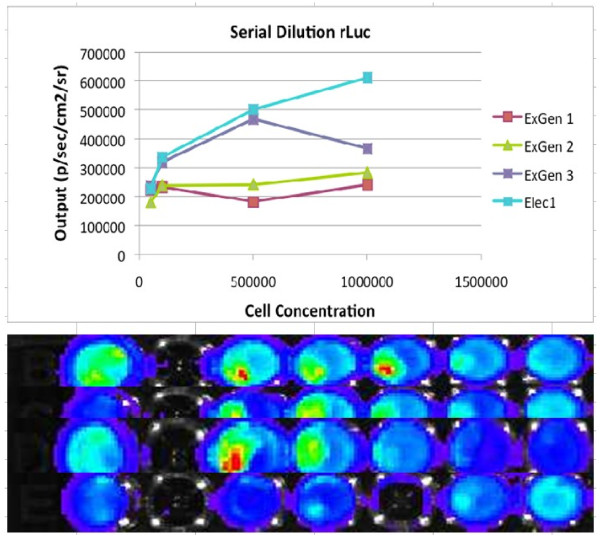
Three independent DLD1/SV-rLuc/ExGen and Two independent DLD1/SV-rLuc/ELec clones were seeded in 96-well plates at different cell densities, ranging from 5 × 10 cells/well to 1 × 106 cells/well and treated with the Renilla luciferase substrate Coelenterazine. 50 μg/ml, output (p/sec/cm2/sr) was recorded using IVIS machine with in 10 second of the substrate addition.